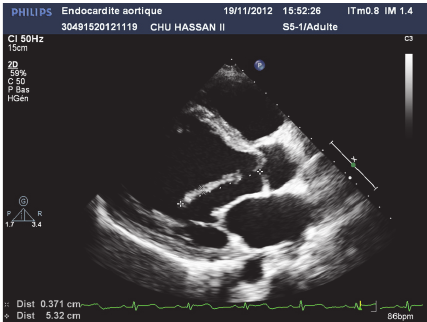
Figure 2: Large mobile vegetation attached to the ventricular side of the left cusp of aortic valve.